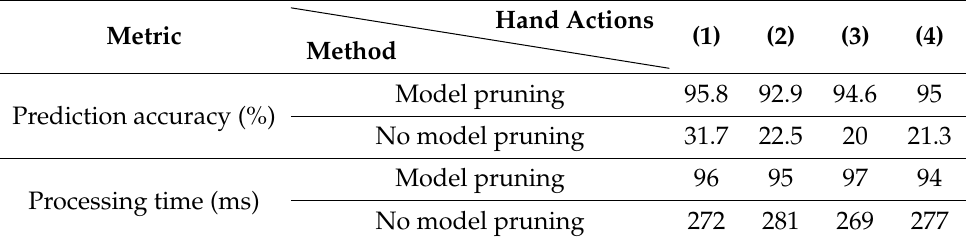
Table 3. Comparison between model pruning and no model pruning.